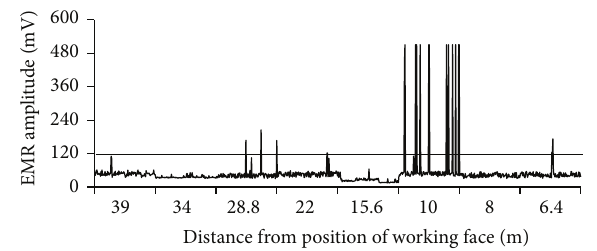
Figure 16: EMR amplitude of monitoring point located 20m ahead of working face in tailentry from September 21 to